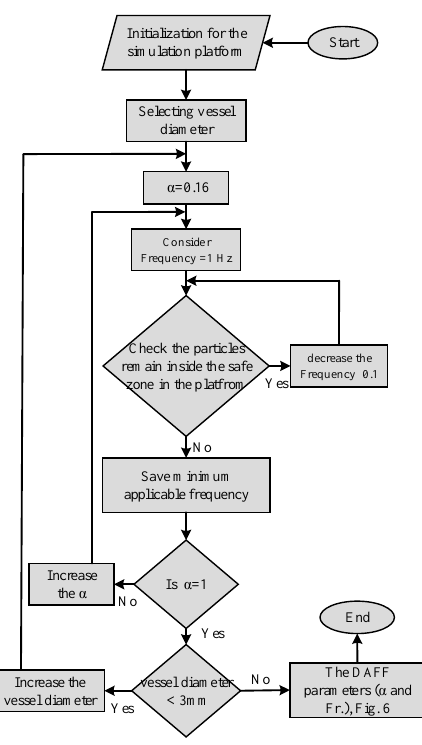
Figure 5. Flowchart of the frequency and α in the discontinuous asymmetrical field function (DAFF).